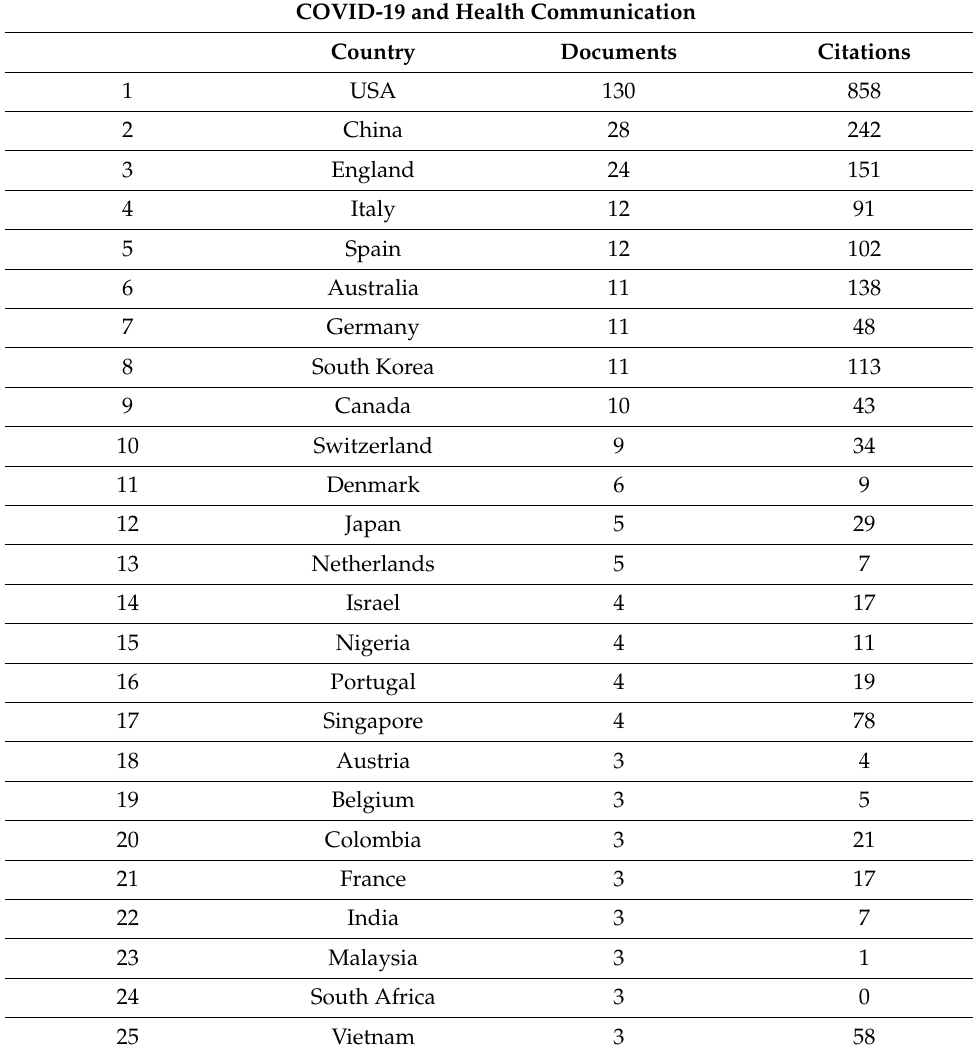
Table 7. Countries, number of articles and citations on COVID-19 and ‘Health